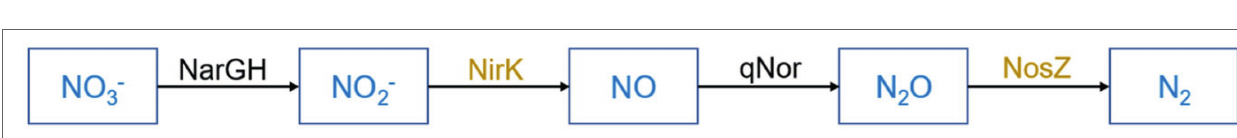
FIGURE 2 | Denitrification pathway described from H. mediterranei . In yellow, copper-containing enzymes NirK and NosZ are represented (NarGH: Nitrate reductase; NirK: Nitrite reductase; qNor: Nitric oxide reductase; NosZ: Nitrous oxide reductase).